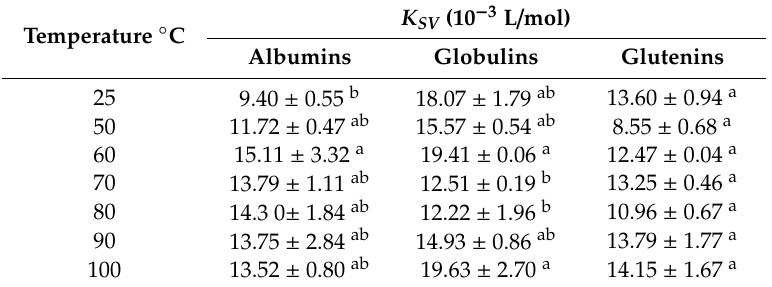
Table 2. The Stern Volmer quenching constant ( K SV ) with acrylamide at di ff erent